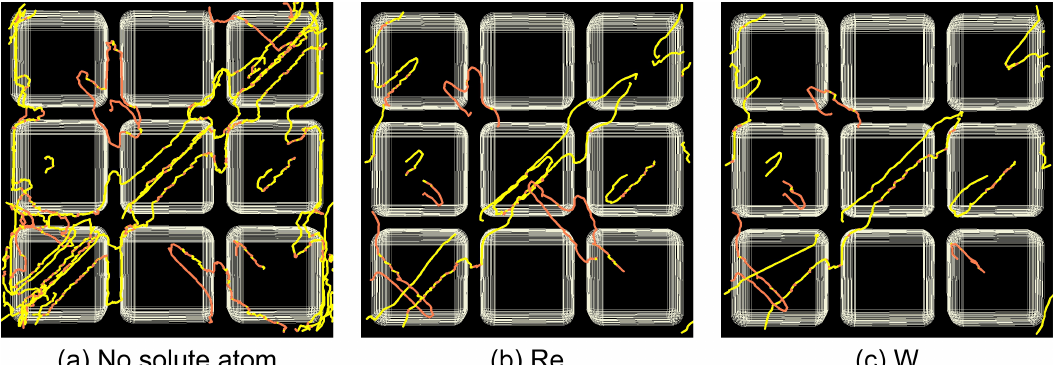
Figure 7. Dislocation patterns in [101](¯1¯11) (yellow) and [101](1¯1¯1) (orange) slip systems in γ matrix channels after 14 s under 200 MPa tensile load along [001] direction at 850 ◦ C for different solute atoms. Dislocations are viewed in the projection on (001) crystallographic planes, corresponding to Figure 1. One dislocation line containing some dislocation jogs with another color indicates the occurrence of dislocation climb: ( a ) no solute atom; ( b ) 7 × 10 − 3 at.% Re; and ( c ) 7 × 10 − 3 at.%